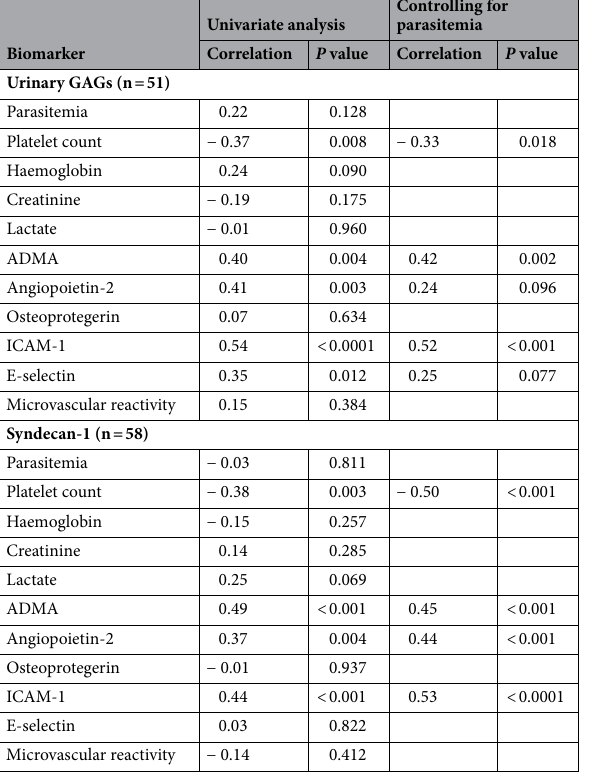
Table 3. Partial correlation coefficients between glycocalyx breakdown products and markers of severity in vivax malaria. After applying Bonferonni’s correction for the 11 variables evaluated in the correlation analyses above, correlations were considered statistically significant if p < 0.0045. GAGs glycosaminoglycans, ADMA asymmetric dimethylarginine, ICAM-1 intercellular adhesion